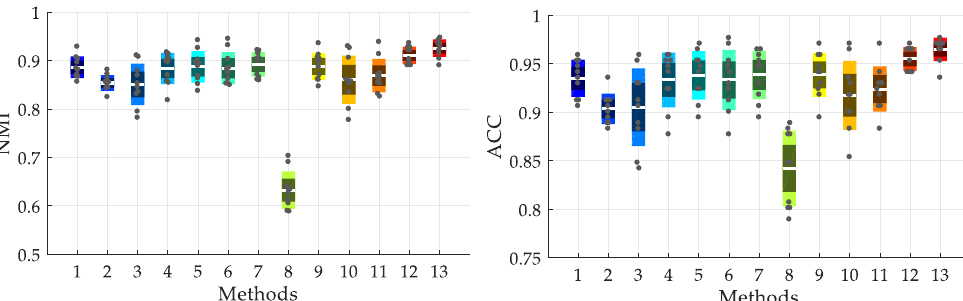
Figure 11. Boxplots of evaluation values for different methods, the x-axis tick labels correspond to: 1: vector machine (SSFCM-ASCA-SVM) (0.3); 2: constrained-K-means, adaptive sine cosine algorithm and support vector data description with improved decision strategy (CK-means-ASCA-ID-SVDD) (0.3); 3: semi-supervised fuzzy C-means clustering, adaptive sine cosine algorithm and support vector data description with relative distance decision strategy (SSFCM-ASCA-RD-SVDD) (0.3); 4: semi-supervised fuzzy C-means clustering, sine cosine algorithm and support vector data description with improved decision strategy (SSFCM-SCA-ID-SVDD) (0.3); 5: semi-supervised fuzzy C-means clustering, adaptive sine cosine algorithm and support vector data description with improved decision strategy (SSFCM-ASCA-ID-SVDD) (0.3); 6 CK-means-ASCA-SVM (0.5); 7: SSFCM-ASCA-SVM (0.5); 8: fuzzy C-means clustering, adaptive sine cosine algorithm and support vector data description with improved decision strategy (FCM-ASCA-ID-SVDD )(0.5); 9: CK-means-ASCA-ID-SVDD (0.5); 10: SSFCM-SCA-RD-SVDD (0.5); 11: SSFCM-ASCA-RD-SVDD (0.5); 12: SSFCM-SCA-ID-SVDD (0.5); 13: SSFCM-ASCA-ID-SVDD